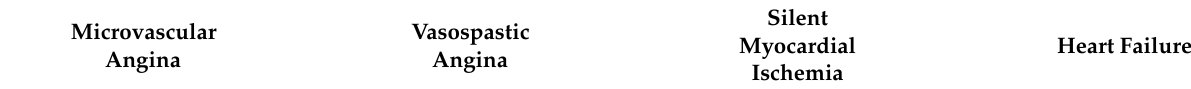
Table 2. Prognostic clinical variables corresponding to appropriate use criteria for an imaging test in special groups of patients with chronic stable coronary artery disease.